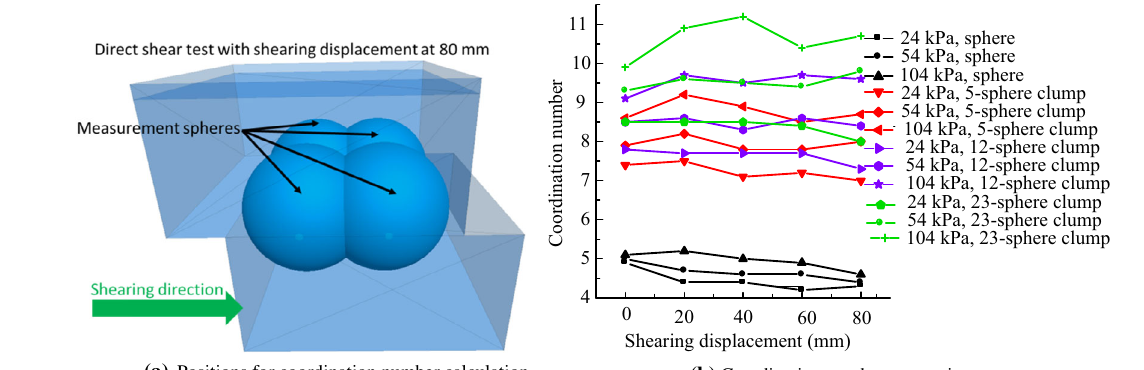
Fig. 9 Coordination number comparison of the sphere